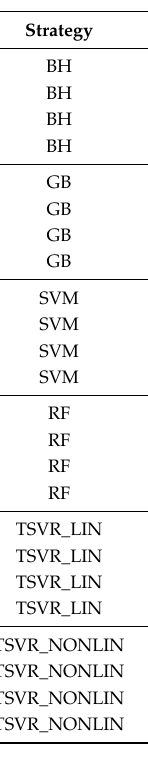
Table 7. Single predictors’ performance after a tuning process optimized by accuracy.